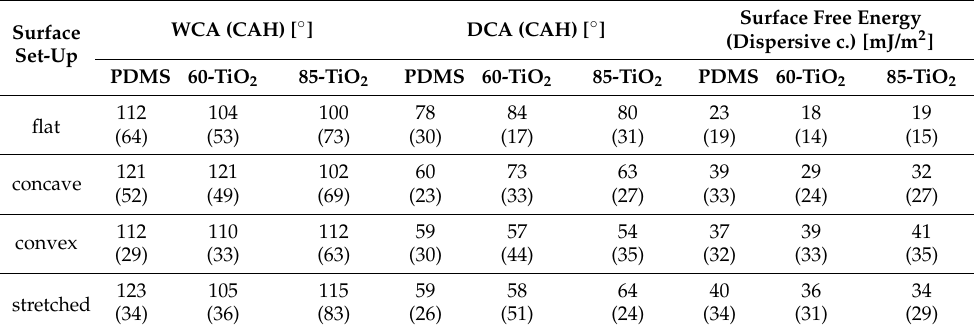
Table 2. Wetting behavior of PDMS and TiO 2 /PDMS surfaces: static contact angles with water (WCA) and diiodomethane (DCA), contact angles hysteresis (CAH) in brackets and surface free energy (dispersive component in brackets) of the samples under different strained